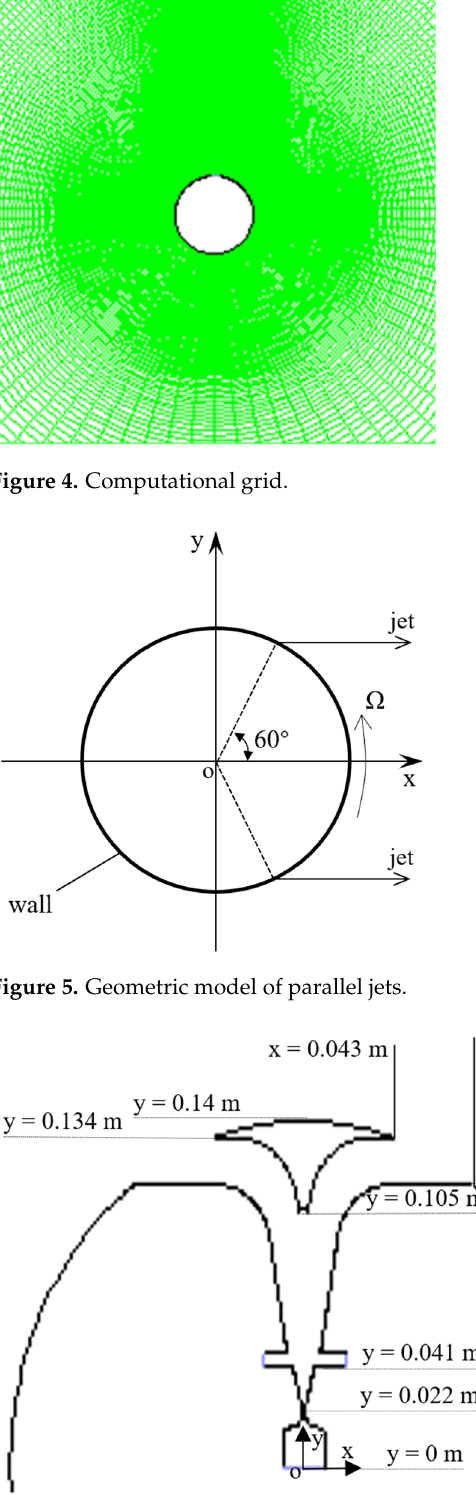
Figure 3. Computational domain and boundary conditions.